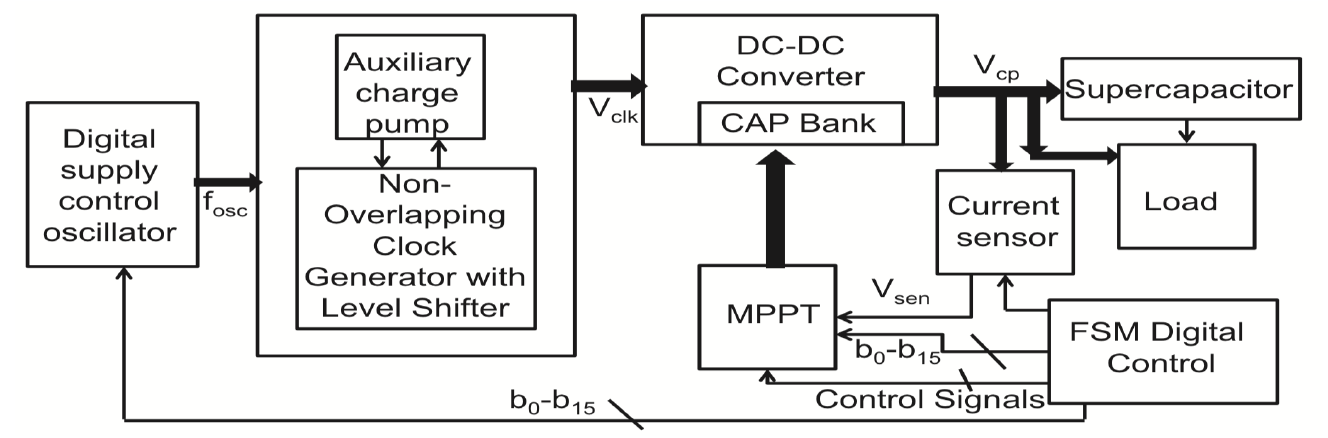
Figure 16. The concept schematic of the EHS presented in